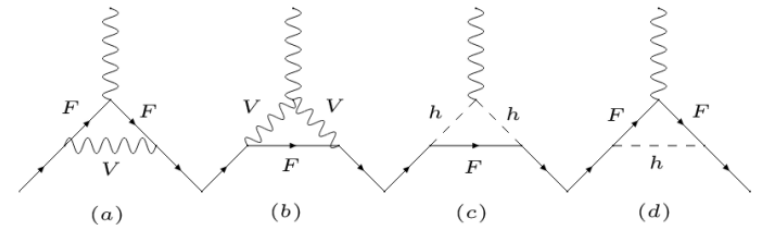
Figure 5 . The diagrams contributing to the muon anomalous magnetic moment. The second diagram is not generated in SM (cid:10) U(1) X